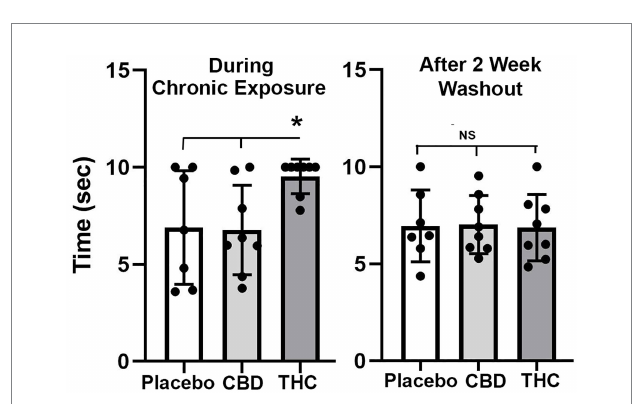
FIGURE 2 Tail flick. Shown are scatter plots for time to withdraw the tail from the hot water bath for each of the experimental groups during chronic exposure and following a two-week washout. The bar and line represent the mean and SD. (* p <